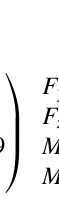
Figure 9. Linearity